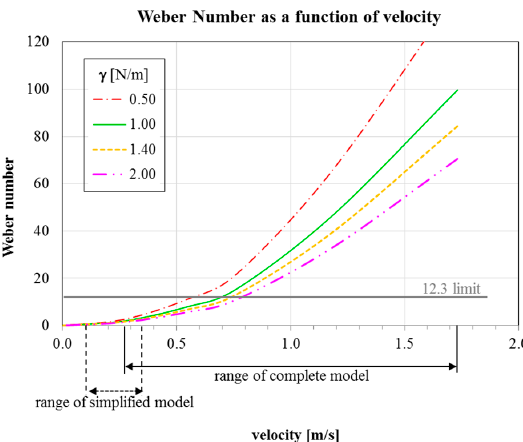
Figure 10. Variation of the Weber number as a function of the steel-powder interfacial tension.